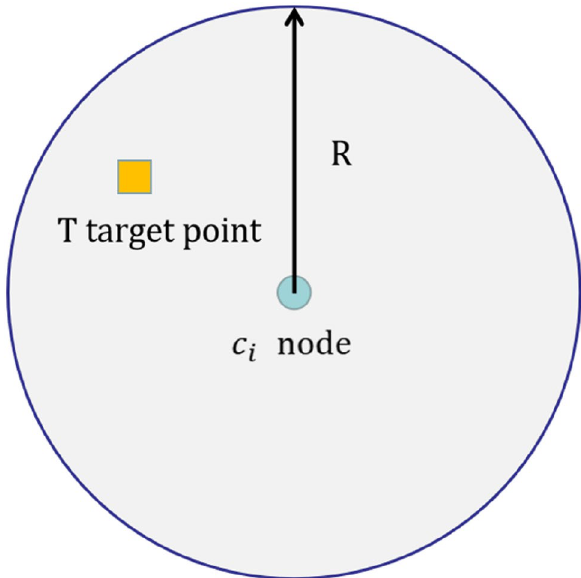
Figure 2. Boolean perception